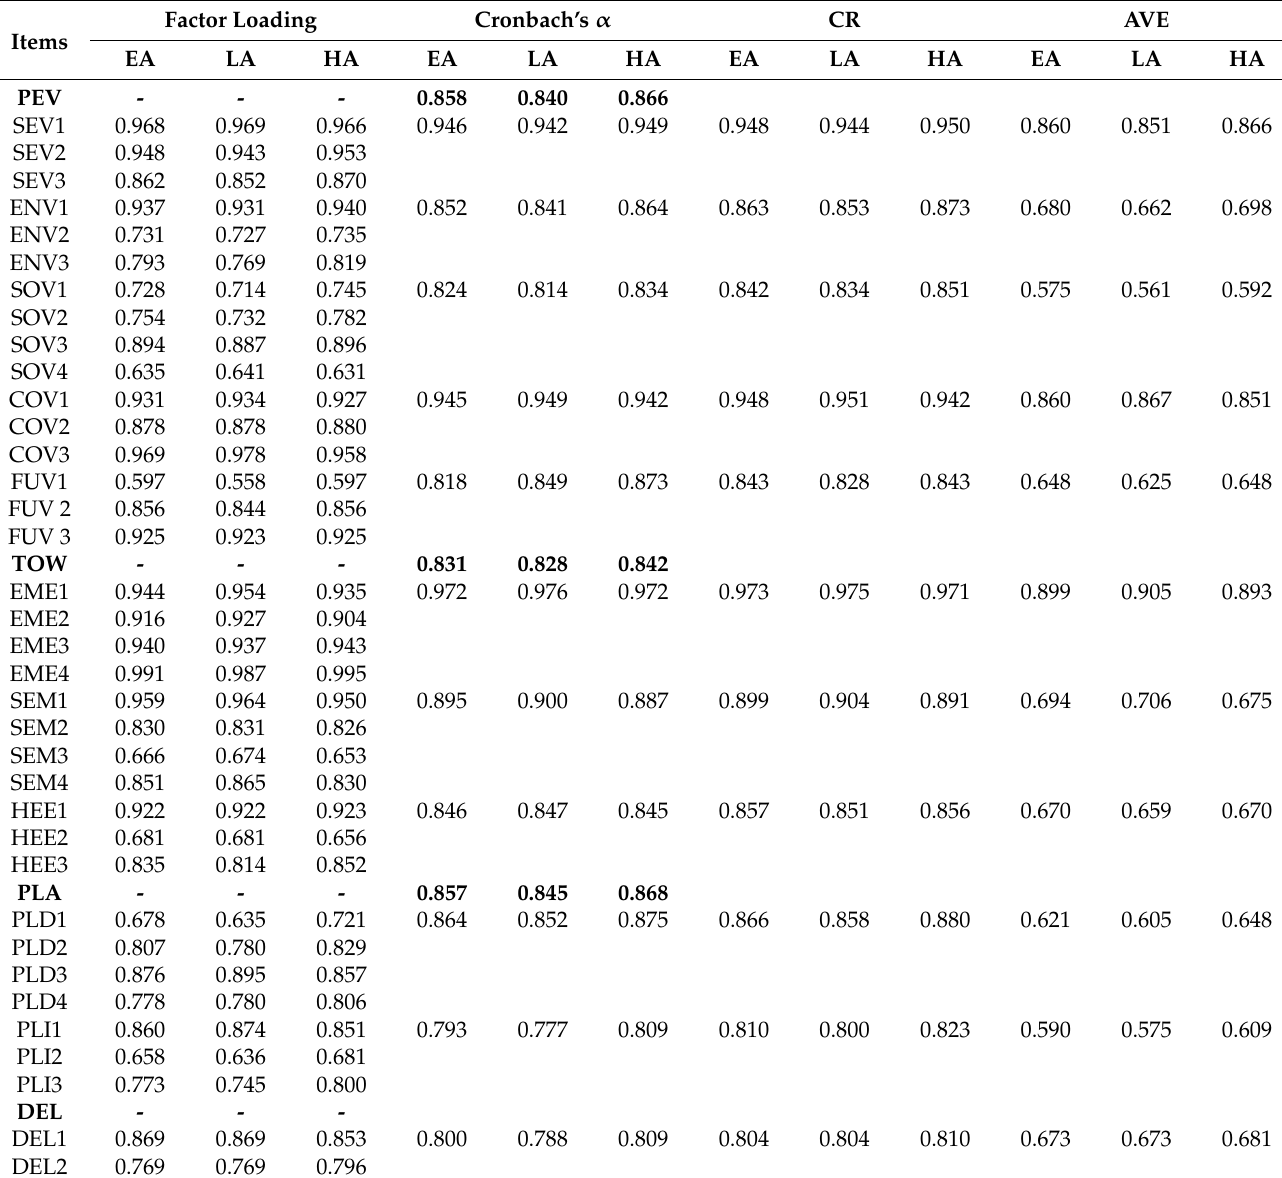
Table 4. Results of the measurement model